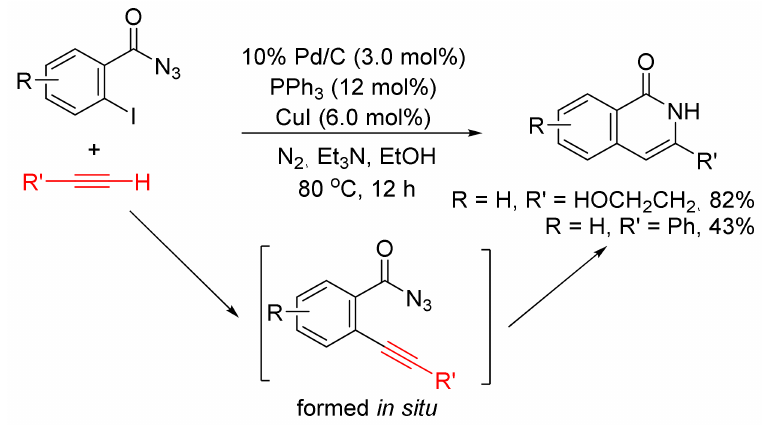
Scheme 29. Isoquinolone formation via intramolecular cyclization of ortho -alkynylbenzoyl azides. In the presence of H 2 O, Cu(OAc) 2. H 2 O-catalyzed tandem cyclization reaction of 2-(1- alkynyl)arylaldimines produces highly substituted isoquinolone derivatives (Scheme 30) [99].